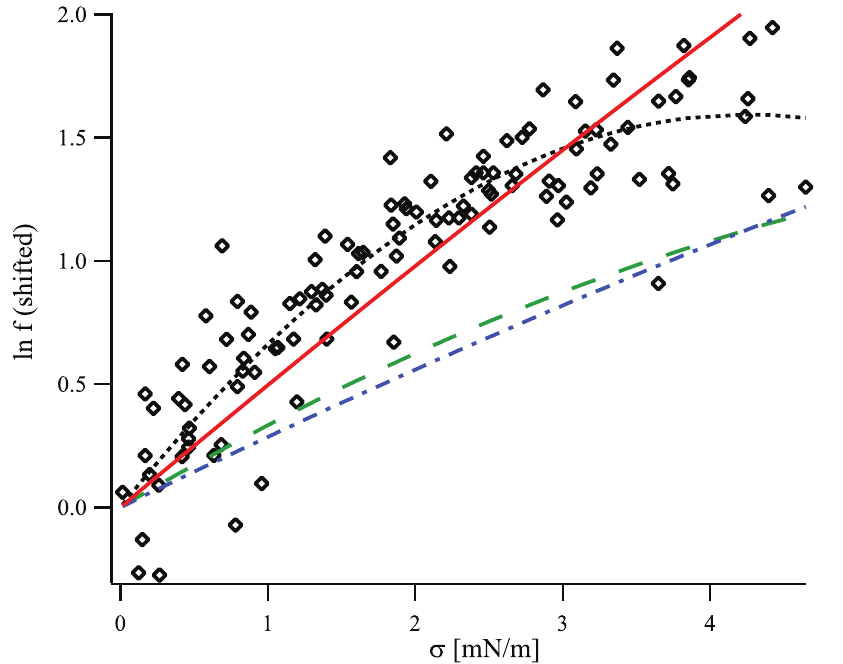
Figure 7. Formation rate f of gramicidin channels versus the applied tension s , analyzed with a quadratic model. Diamonds: . Dotted black line: best quadratic fit, with experimental data retrieved from Fig. 6b of Ref. [18], after subtraction of the baselines C k 0 C 1 ~ 0 : 74(mN = m) { 1 and C 2 ~{ 0 : 09(mN = m) { 2 ; x 2 : x 2 . Dashed green line: results obtained from the elastic model of Ref. [22], with the constants min ~ 5 : 72 . Dashed-dotted blue line: idem with more recent values of the constants; x 2 = x 2 ~ 6 : 68 . Solid red line: results obtained given in [18]; x 2 = x 2 min min ~ 1 : 75 . The values of C by taking s ~ 0 and the recent values of the constants in the model of Refs. [7,22]; x 2 = x 2 1 and C 2 corresponding to the curves min on this graph are listed in Table